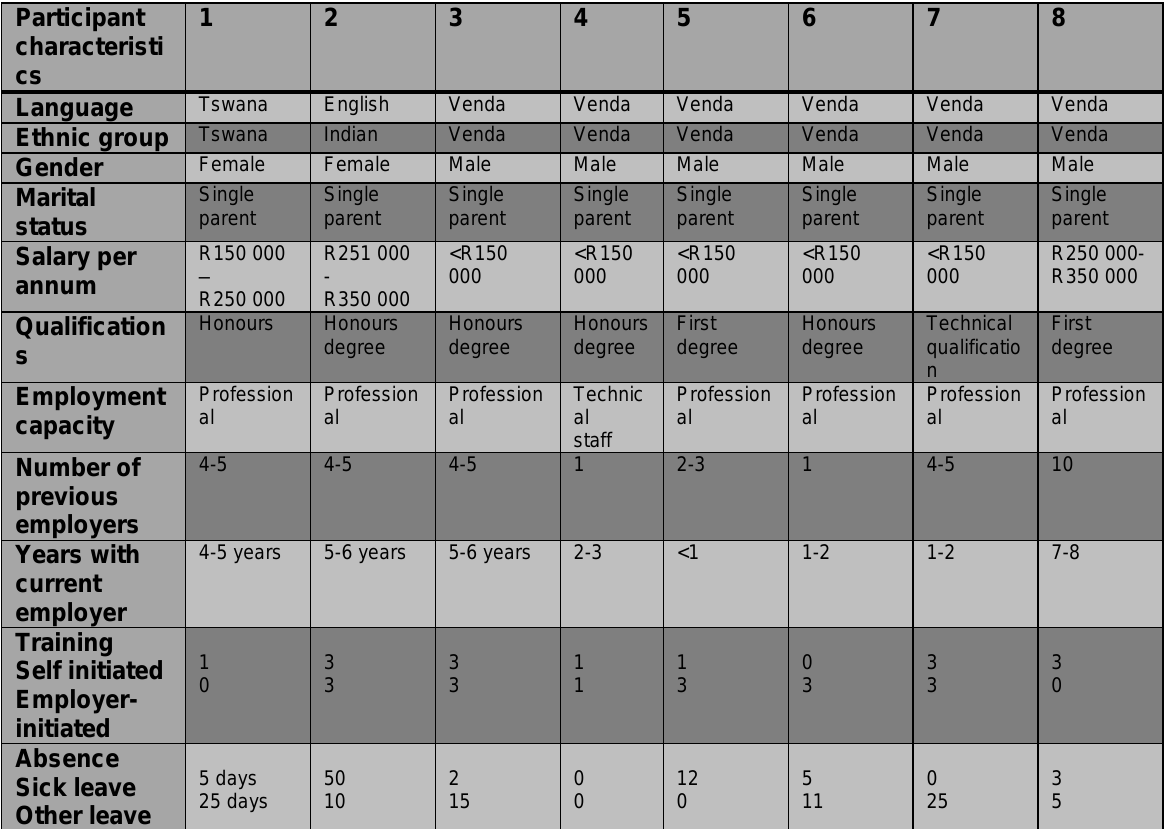
Table 1: Profile of participants